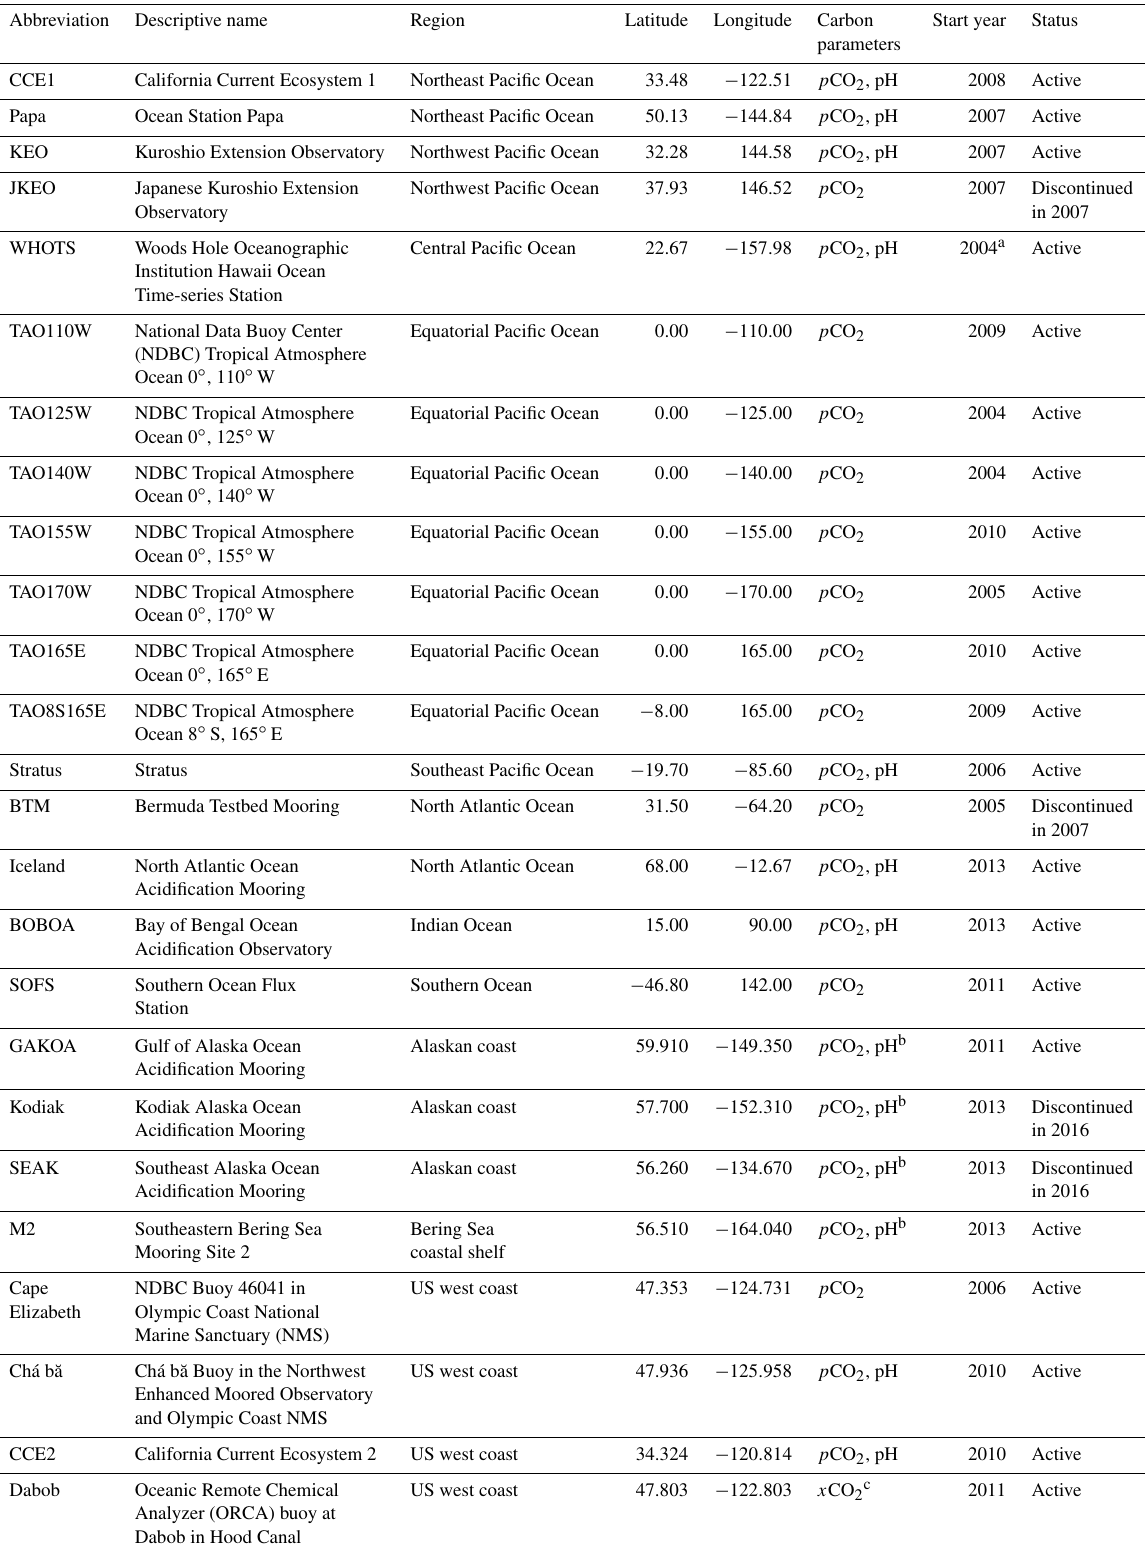
Table 1. Region, coordinates, surface ocean carbon parameters measured, year carbon time series established, and current status of the